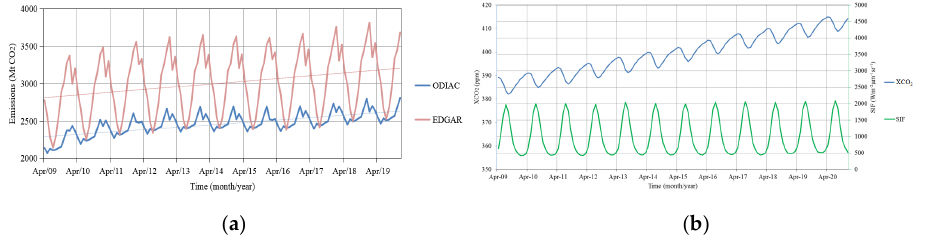
Figure A3. Temporal variations of ( a ) averaged emissions of ODIAC, EDGAR, and ( b ) XCO 2 and SIF in the Northern Hemisphere.